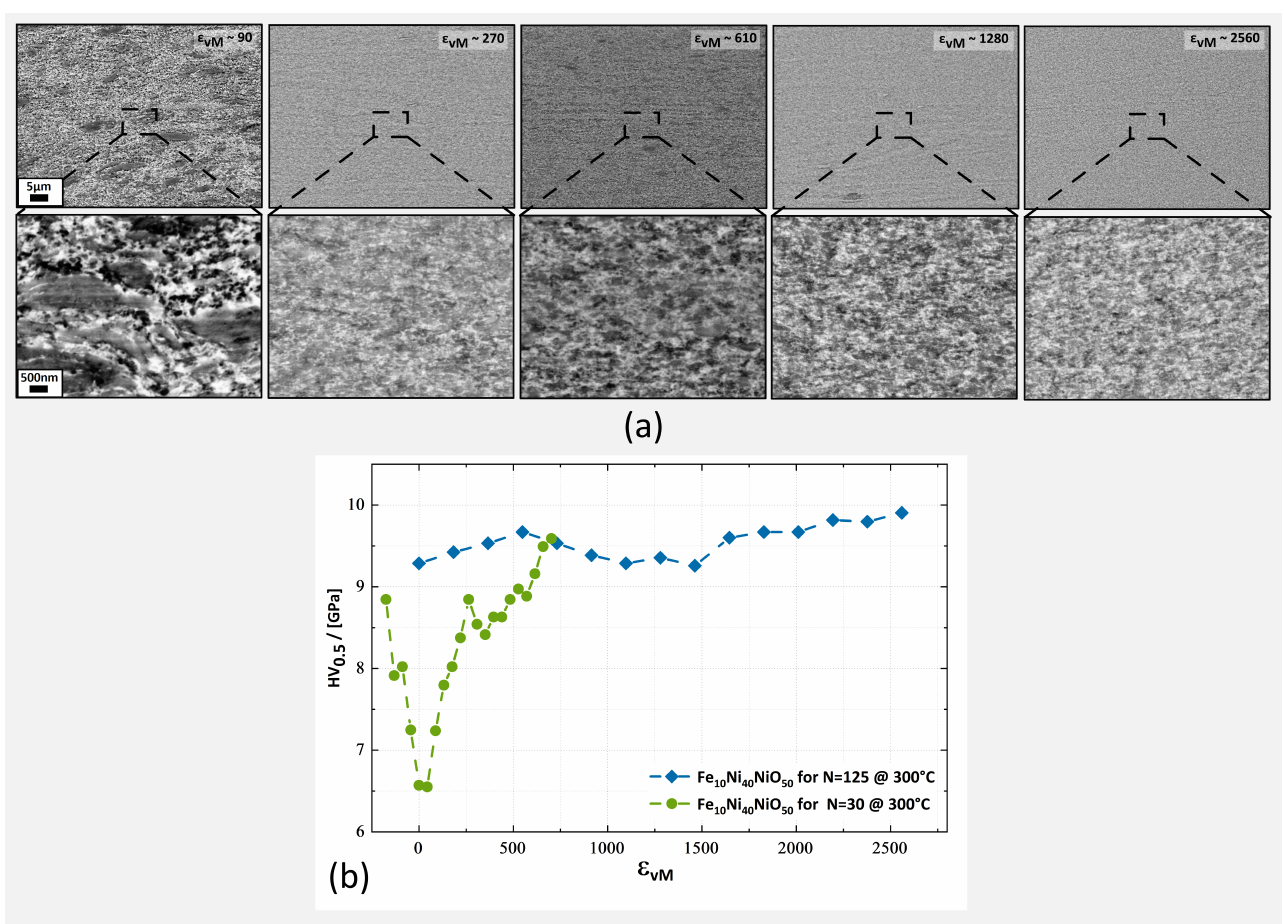
Figure 3. ( a ) BSE micrographs of the Fe 10 Ni 40 NiO 50 samples. Microstructural refinement was detected from left to right. Two samples were deformed to obtain the depicted micrographs. First samples were deformed with 30 rotations and micrographs of an applied strain of (cid:101) vM ∼ 90 to (cid:101) vM ∼ 610 were taken. The second samples were deformed with 125 rotations and micrographs of an applied strain of (cid:101) vM ∼ 270, (cid:101) vM ∼ 1280 and (cid:101) vM ∼ 2560 were taken. The micron bar applies to all micrographs in the same row. ( b ) Vickers microhardness of both Fe 10 Ni 40 NiO 50 samples deformed at 300